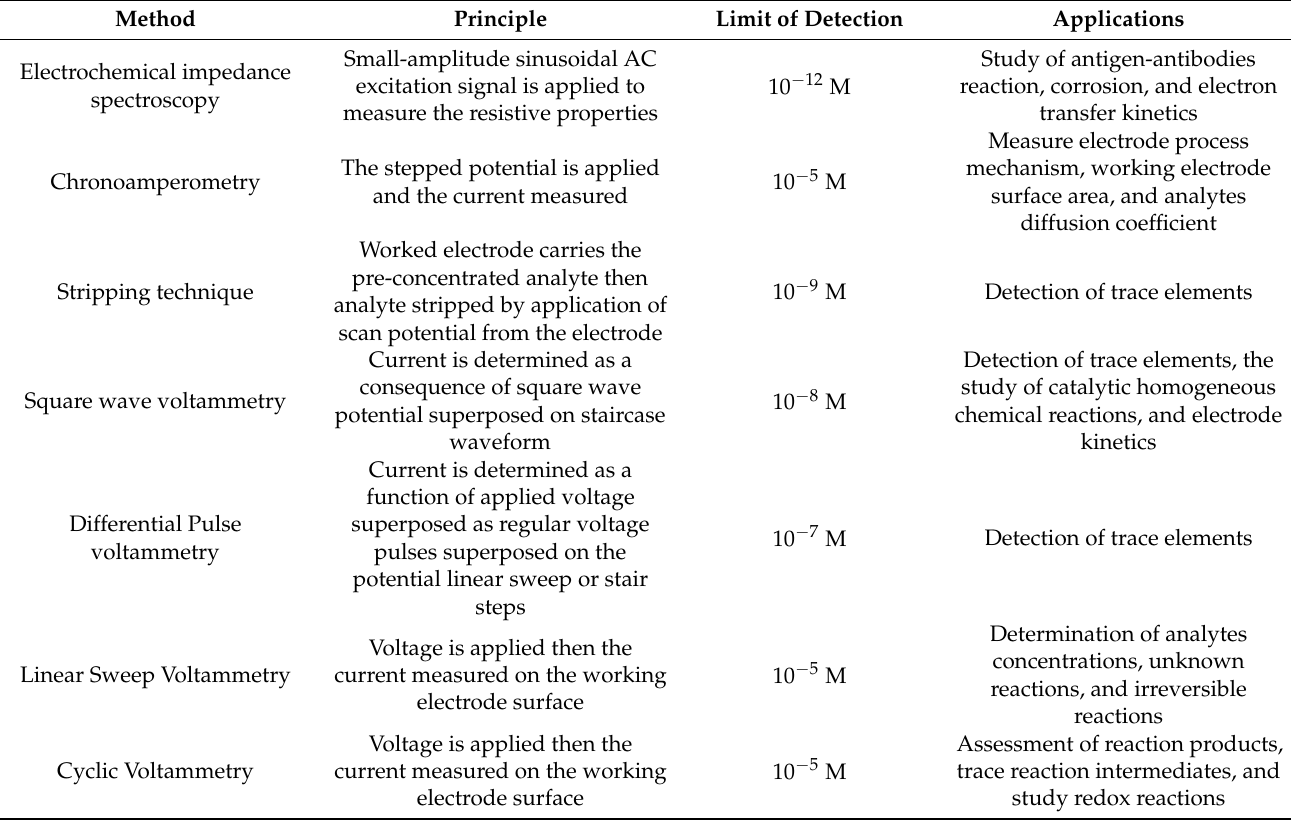
Table 1. The different electrochemical techniques used for sensing